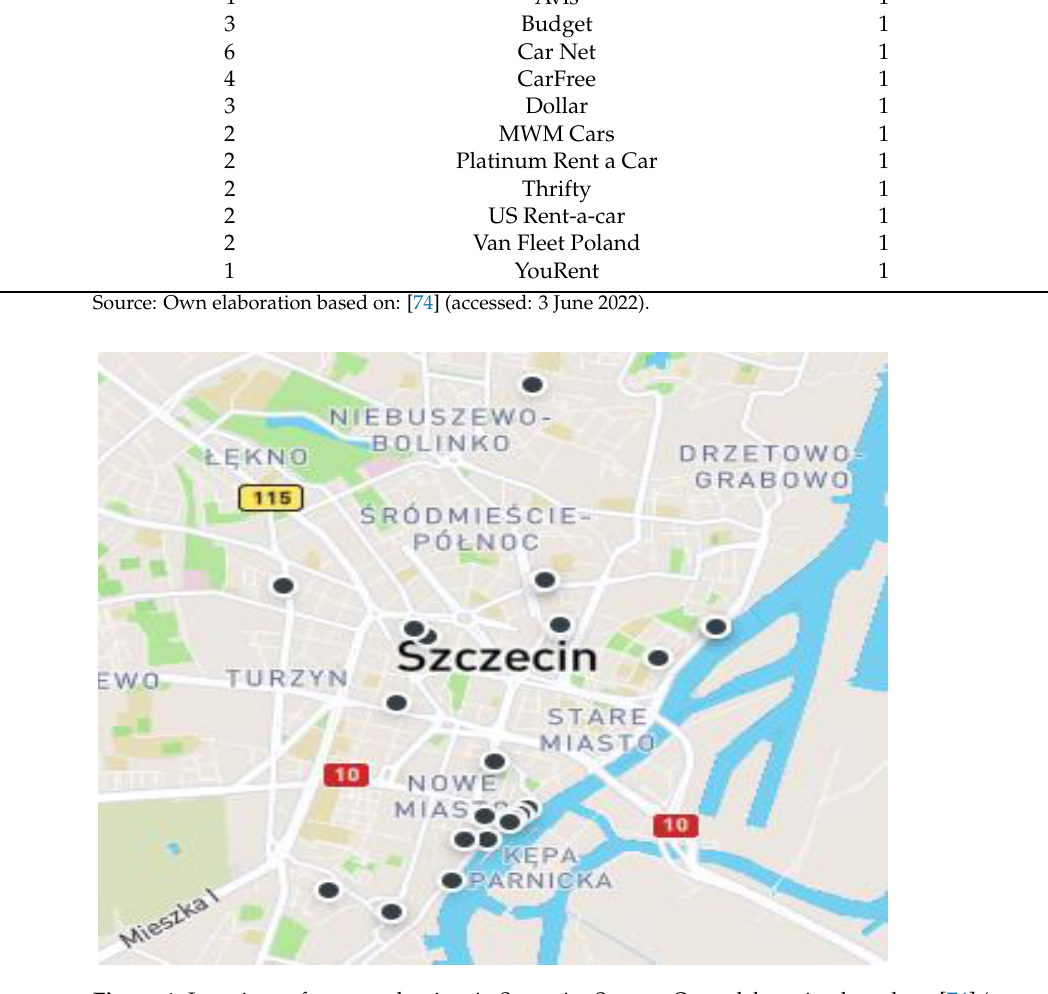
Figure 1. Locations of car rental points in Szczecin. Source: Own elaboration based on: [74] (accessed: 3 June 2022).